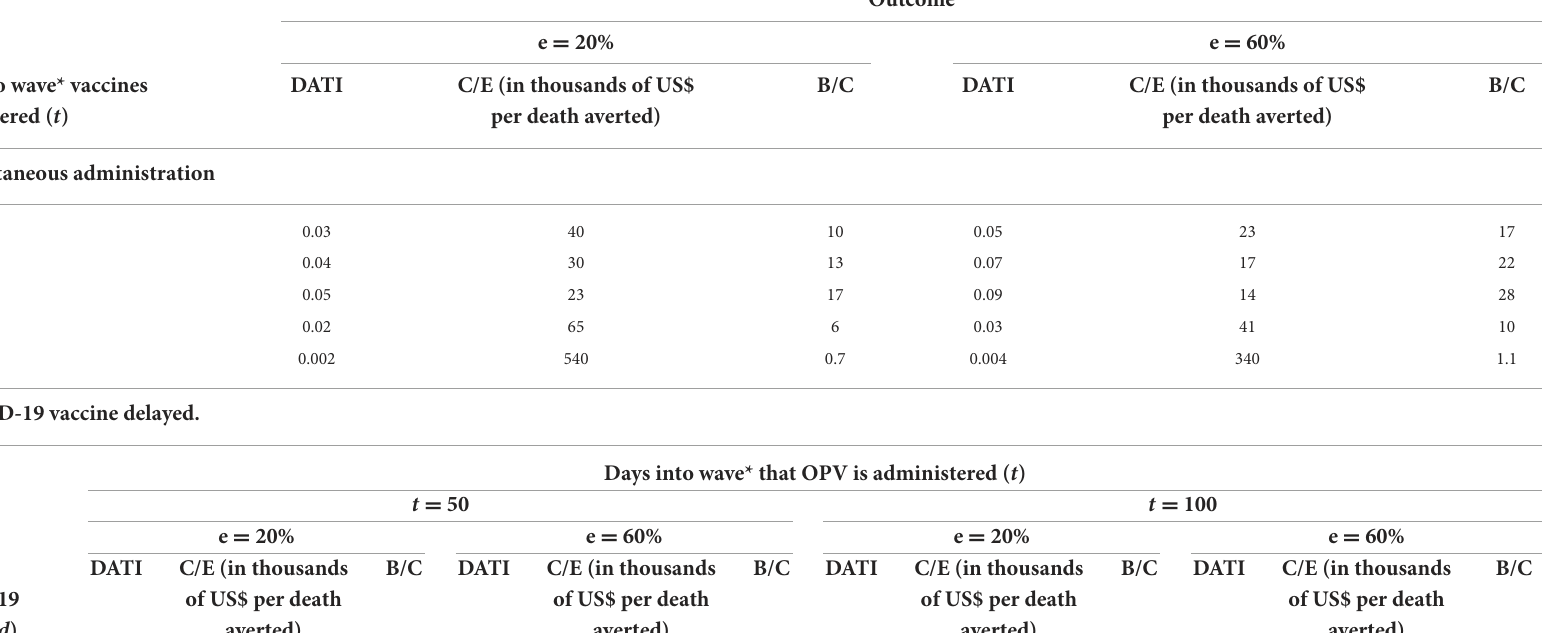
TABLE 2 Outcomes of COVID-19 vaccine + OPV